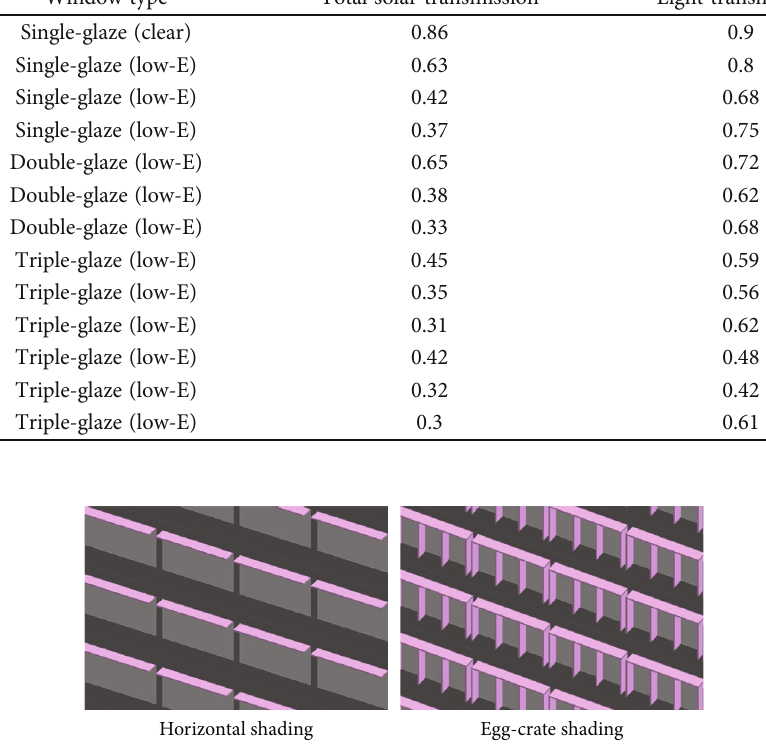
Figure 18: Horizontal and egg-crate shading